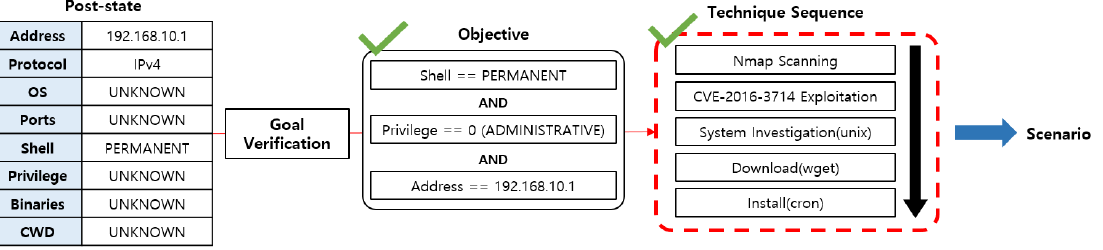
Figure 7. The example of the process of scenario generation: completion of generating a